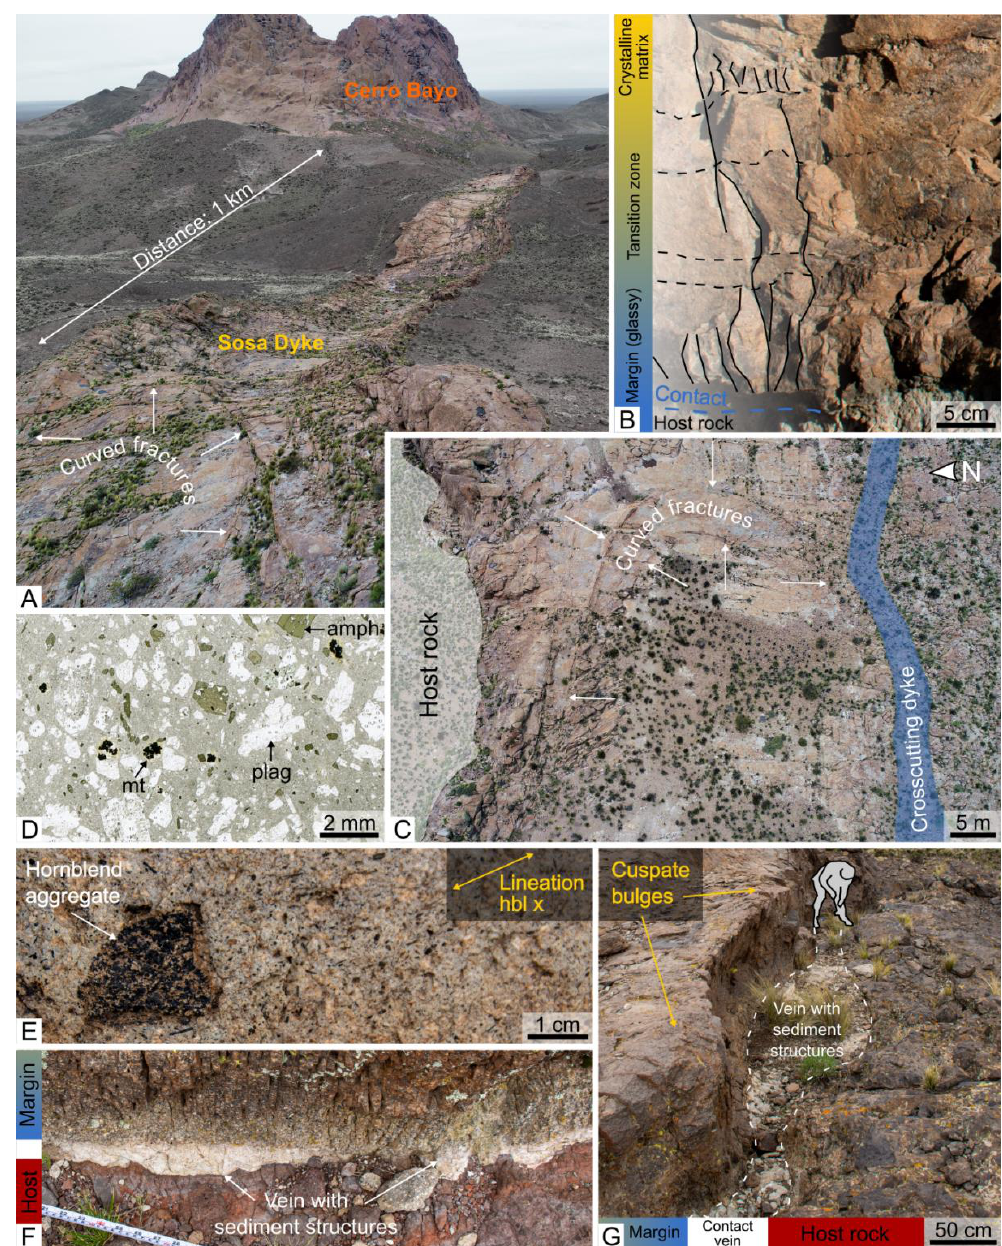
Figure 3. Sosa Dyke features. ( A ) View towards the East from the thickened mid-point in segment I, with Cerro Bayo crypto-dome in the background; curved fractures indicated by white arrows. ( B ) Close-up of margin with cooling joints at contact and second parallel fracture set at the inner end of the transition zone (solid black lines); contact parallel fractures (black dashed lines). ( C ) Top view on Sosa Dyke segment III (see Figure 4 for location), younger cross-cutting dyke and curved fractures toward the East indicated by white arrows. ( D ) Thin section, plain polarized light (PPL) from sample T1-05; white plagioclase phenocrysts, the fine-crystalline matrix consists of plagioclase, with minor amounts of mafic minerals; amph = amphibole group mineral, i.e., hornblende, mt = magnetite/Ti-magnetite; plag = plagioclase. ( E ) Photo shows large hornblende crystal and preferred orientation of hornblende crystals within the transition zone and the glassy margin of the Sosa Dyke. ( F , G ) Clast-filled veins along the contact between the Sosa Dyke the block and ash flow host rock; thickness less than a cm to around 80 cm; Location in Figure 2-tuffisite veins.